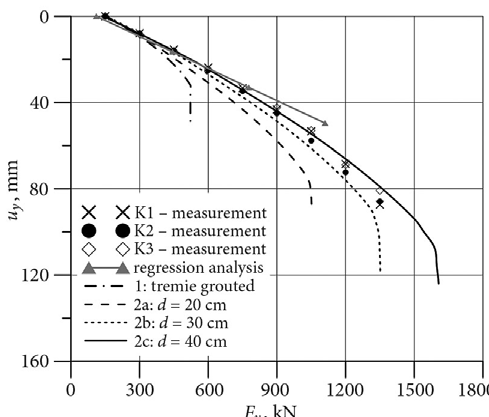
Fig. 11. Comparison of the results of investigation load tests, regression analysis, and numerical analysis